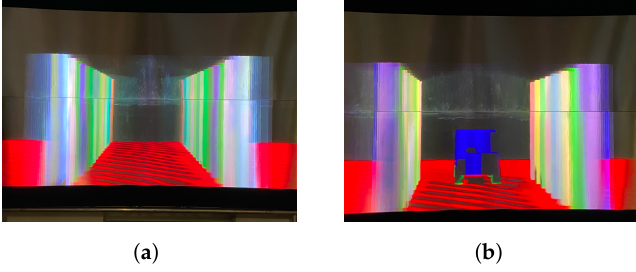
Figure 5. Simulation camera animations. ( a ) FP camera. ( b ) TP